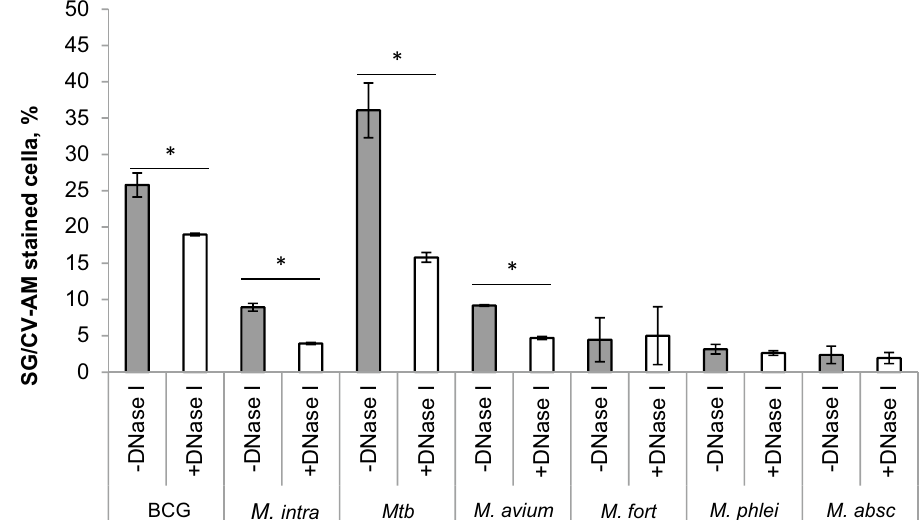
Figure 3. Comparative analysis of eDNA of slow-growing and fast-growing mycobacteria. Percentage of double-stained cells DNase I untreated (− DNase I) or treated (+ DNase I) slow-growing mycobacteria—BCG, M. intracellulare , Mtb , or M. avium, and fast-growing mycobacteria— M. fortuitum, M. phlei, M. abscessus stained with CV-AM/SG. Mean ± SD (n = 3). * p < 0.05, compared to DNase I untreated (− DNase I) and treated (+ DNase I)